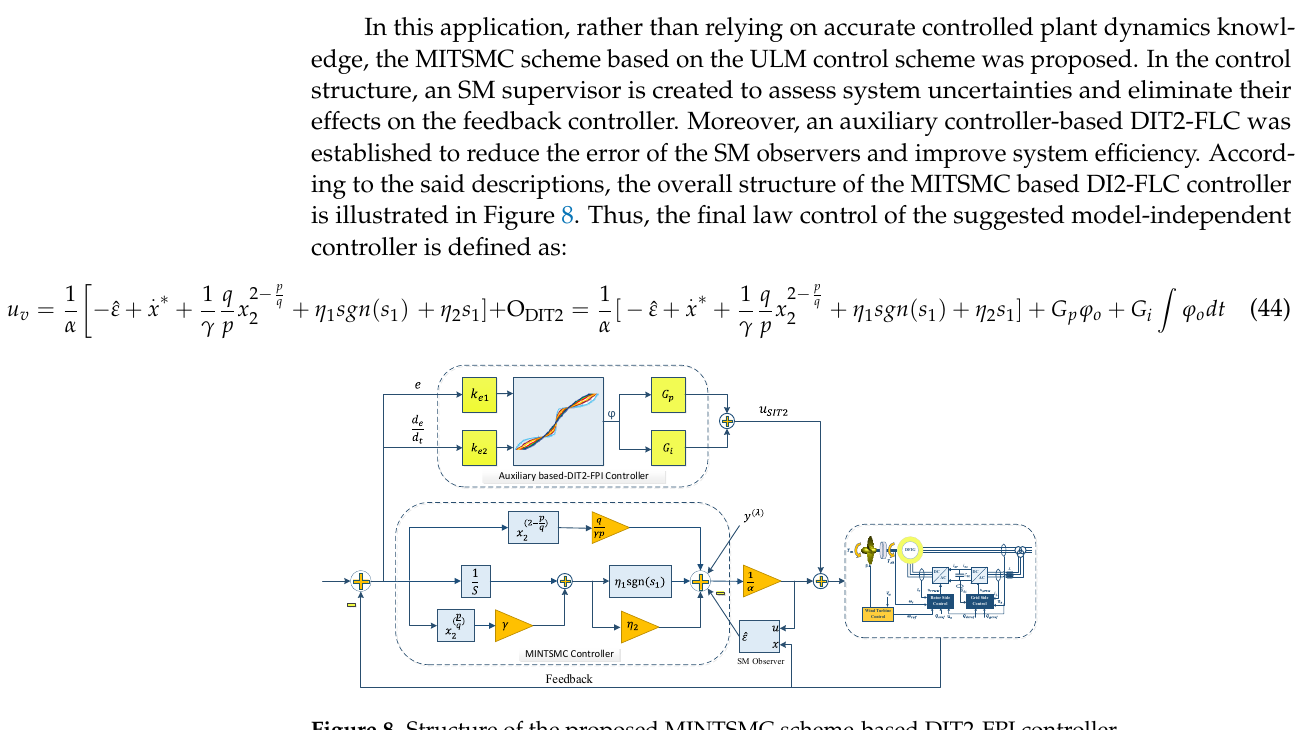
Table 3. Technical parameters of the DFIG WT test system.